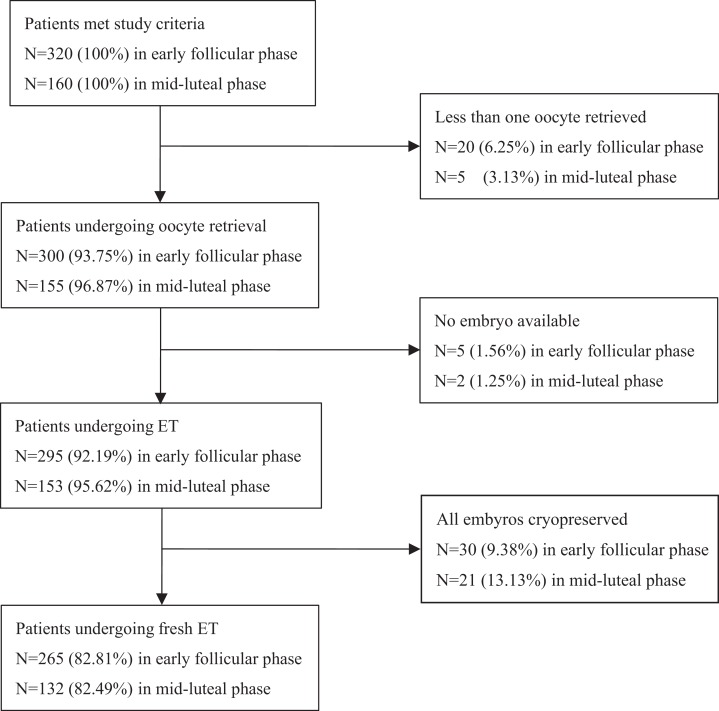
Flow chart describing drop out of enrolled patients.Of the 480 cycles eligible for the study, 20 cycles in Group 1 and five cycles in Group 2 were canceled because fewer than one oocyte was obtained; five cycles in Group 1 and two cycles in Group 2 were cancelled because of no available embryos. Finally, another 30 cycles in Group 1 and 21 cycles in Group 2 were canceled due to the freezing all of the embryos. So 265 cycles in Group 1 and 132 cycles in Group 2 were observed.